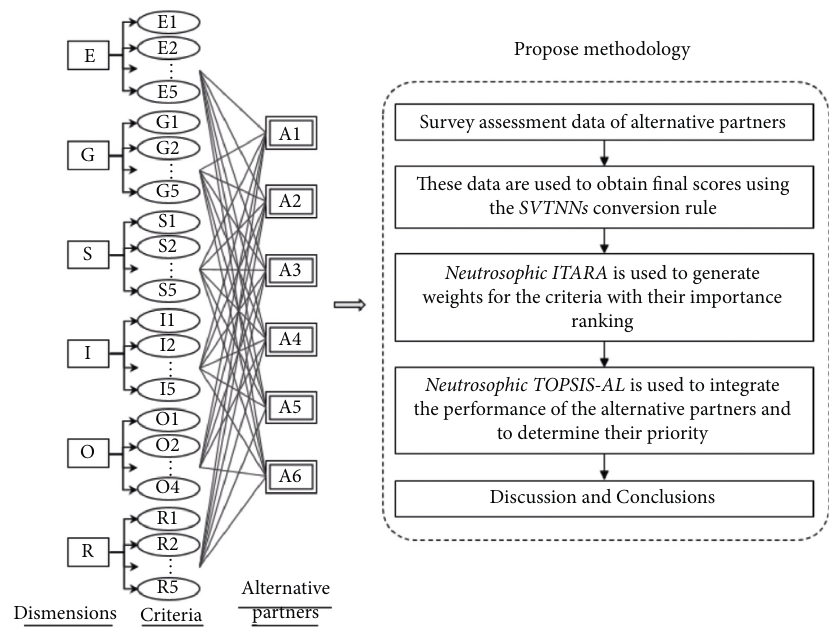
Figure 1: The analysis process